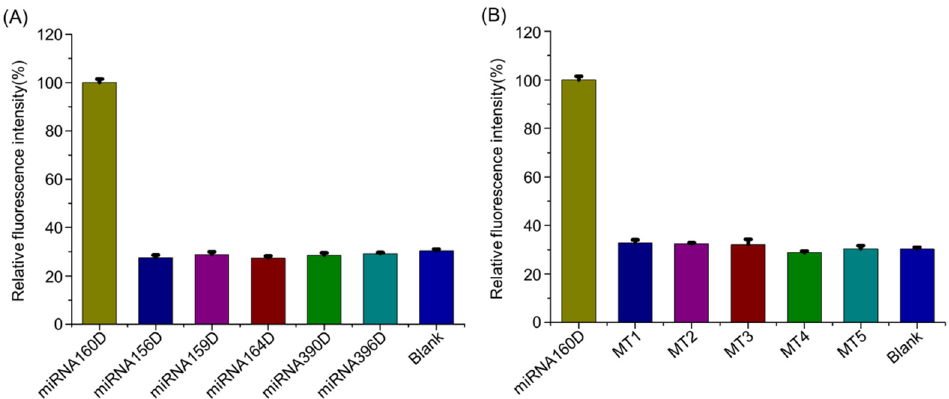
Figure 5. The detection specificity of AMM towards miR160. The fluorescence intensity was recorded upon non-targets ( A ) and mutant targets with one-, two-, three-, four-, and five-base mismatched targets (abbreviated as MT1, MT2, MT3, MT4, and MT5, respectively) ( B ). The concentration of HP1, HP2, HP3, HP4, and target are 250 nM, 250 nM, 250 nM, 250 nM, and 125 nM, respectively. The error bars represent means ± SD ( n = 3).